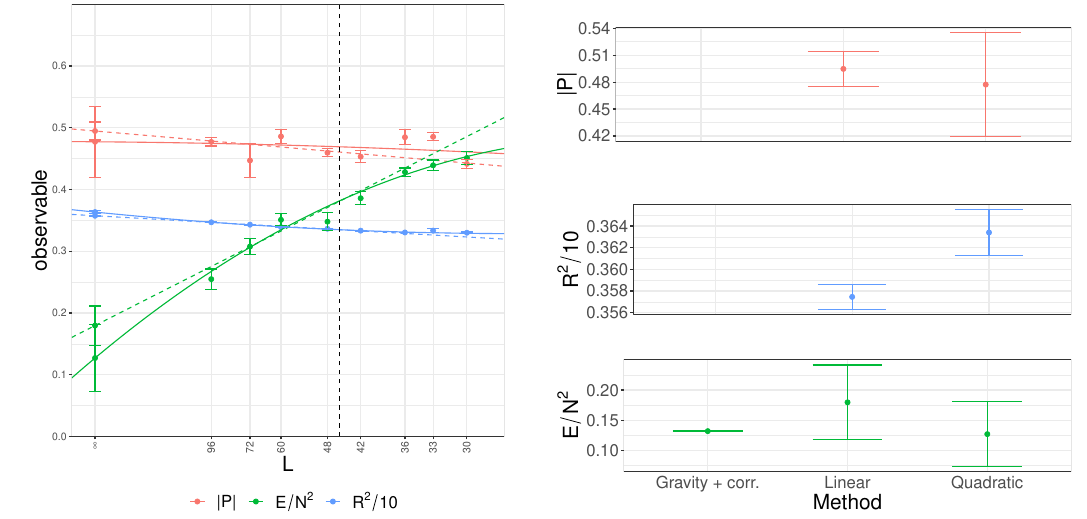
Figure 15 . [Left] Large L extrapolation for T = 0 . 25 , N = 16 , µ = 0 . 5 without constraints imposed. Solid lines are quadratic fits in 1 /L . Dashed lines are linear fits in 1 /L taking into account data points left of the dashed black line. These extrapolation ansätze lead to a consistent extrapolation value. [Right] Results of the continuum extrapolation, including the estimated gravity prediction of the energy. For the energy, we show the value obtained from the fit of the BFSS model at T ≥ 0 . 4 based on (3.28), i.e. using the values for a 1 , a 2 , b 1 as before. As opposed to T = 0 . 3 , we don’t